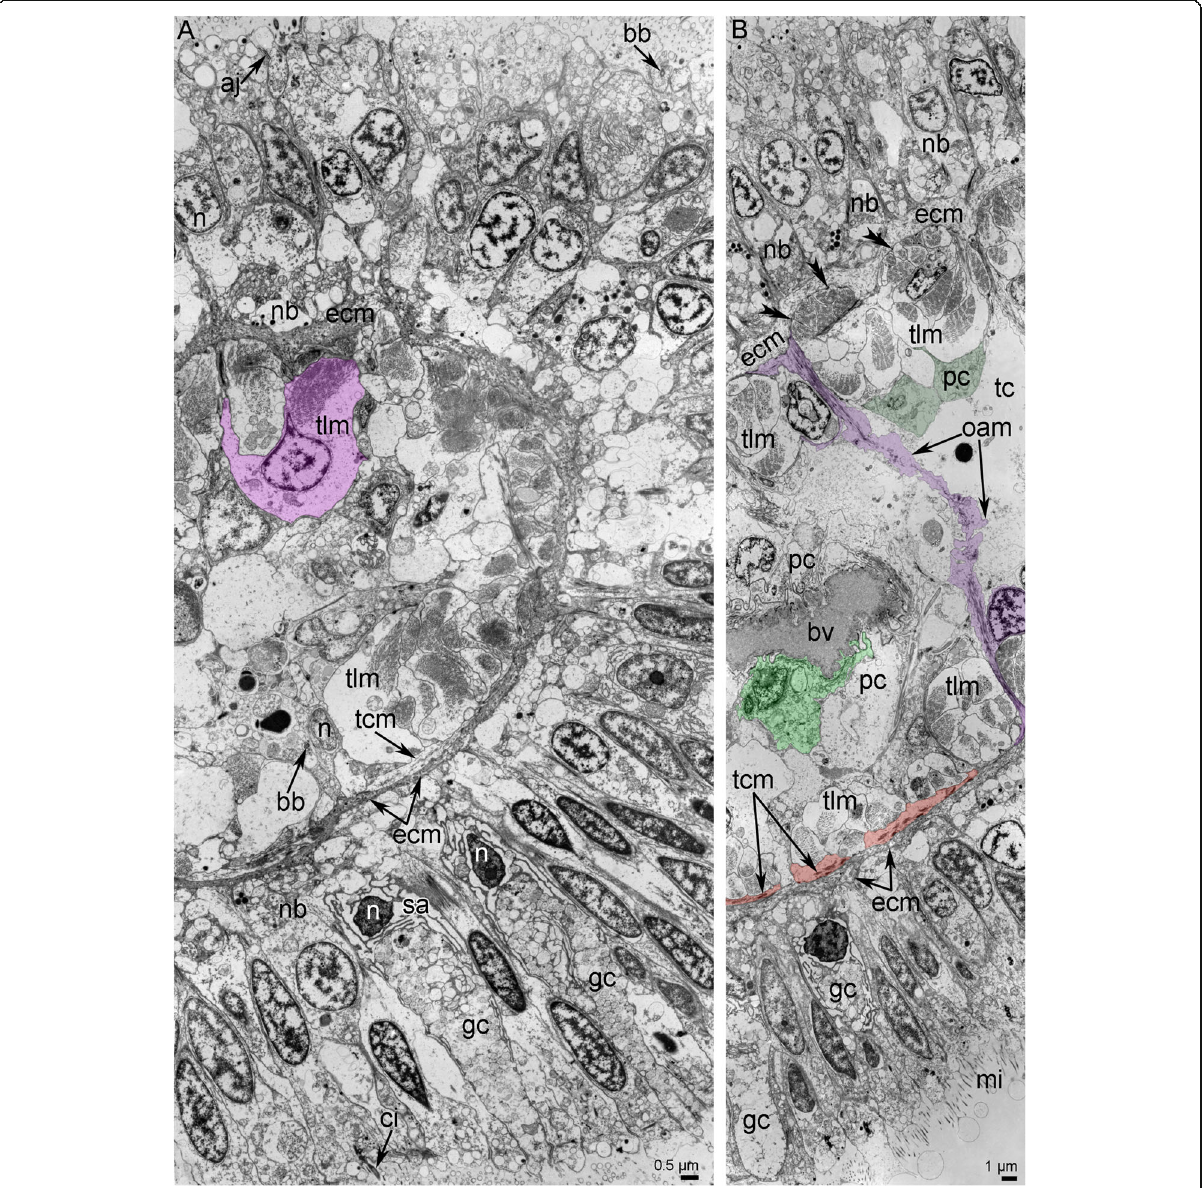
Fig. 3 Details of tentacle ultrastructure of Owenia borealis (TEM). A General view of epithelia and coelomic cavity of a tentacle. A cell of longitudinal muscle is shown in pink. B Different tentacle muscles: oral-aboral muscle is shown in violet, tentacle cross muscles are shown in orange. Peritoneal cells, which cover longitudinal muscles, are shown in dark green. A cell of the wall of blood vessel is shown in light green. Hemidesmosomes are indicated by double arrowheads. Abbreviations: aj – adherence junction; bb – basal body; bv – blood vessel; ci – cilium; ecm – extracellular matrix; gc – gland cell; mi – microvilli; n – nucleus; nb – neurite bundle; oam – oral-aboral muscle; pc – peritoneal cells; sa – secretory area of the gland cell; tcm – tentacle transverse muscles; tlm – tentacle longitudinal